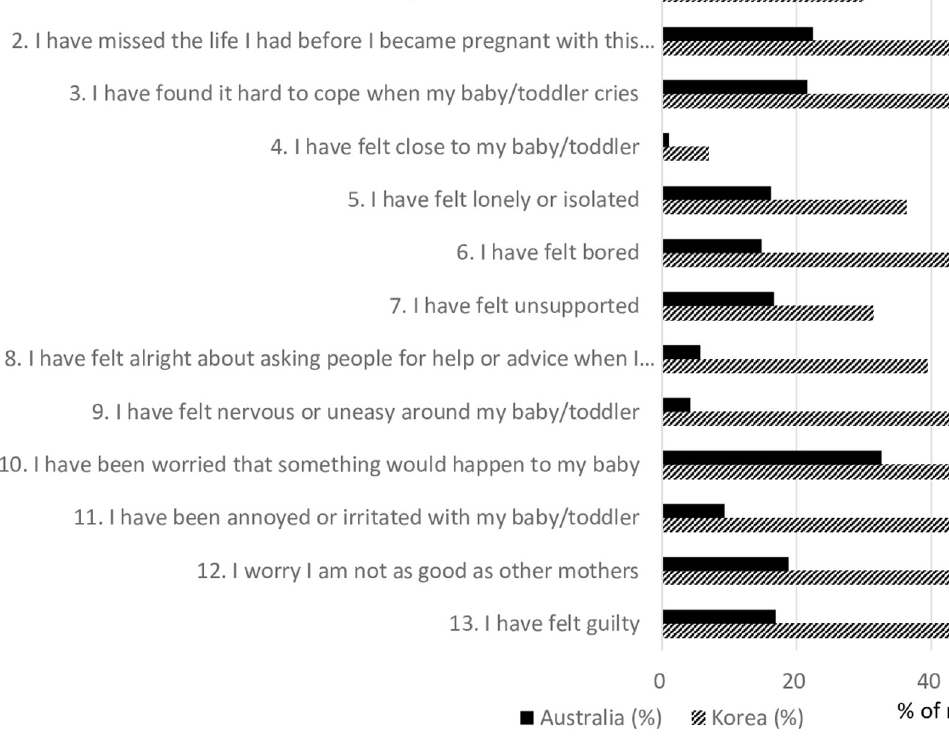
Fig 2. Comparison of each item from the BaM-13 between Korean and Australian mothers � based on the percentage of those who provided a moderate-to-severe negative response (2 or 3 points). � Australian data were from Matthey [7].